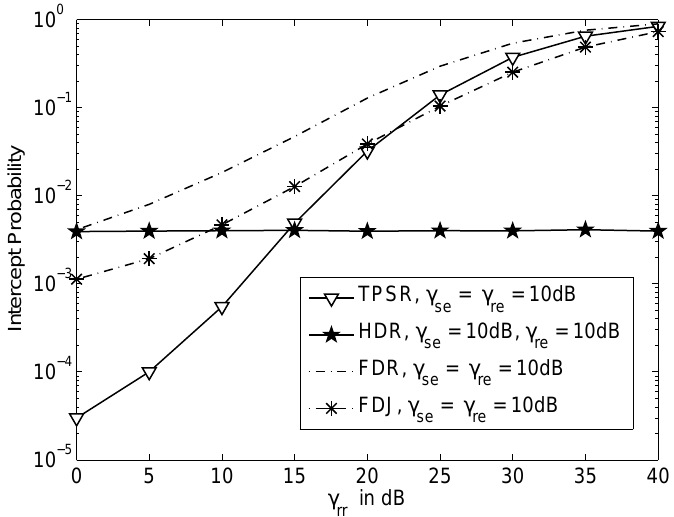
Figure 4. Intercept probability versus inter-relay interference or residual self-interference, γ rr where γ sr = γ rd = 40dB and γ se = γ re =